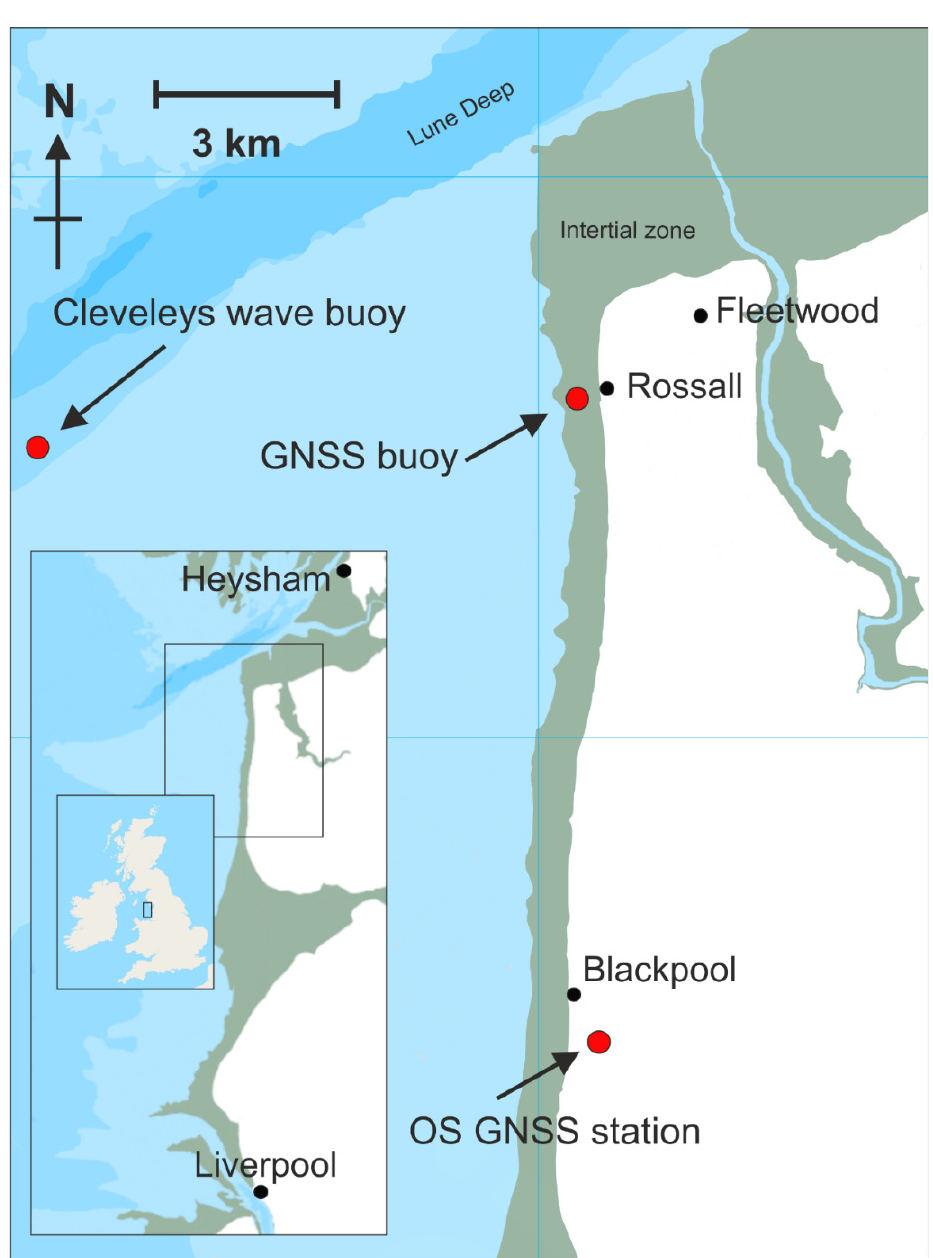
Figure 2. Location of Rossall experiment (Lancashire, UK); GNSS buoy, Ordnance Survey GNSS station, Cleveleys wave buoy. Base map source: EDINA Marine Digimap Service (http://edina.ac.uk/digimap) (accessed on 1 June 2021).